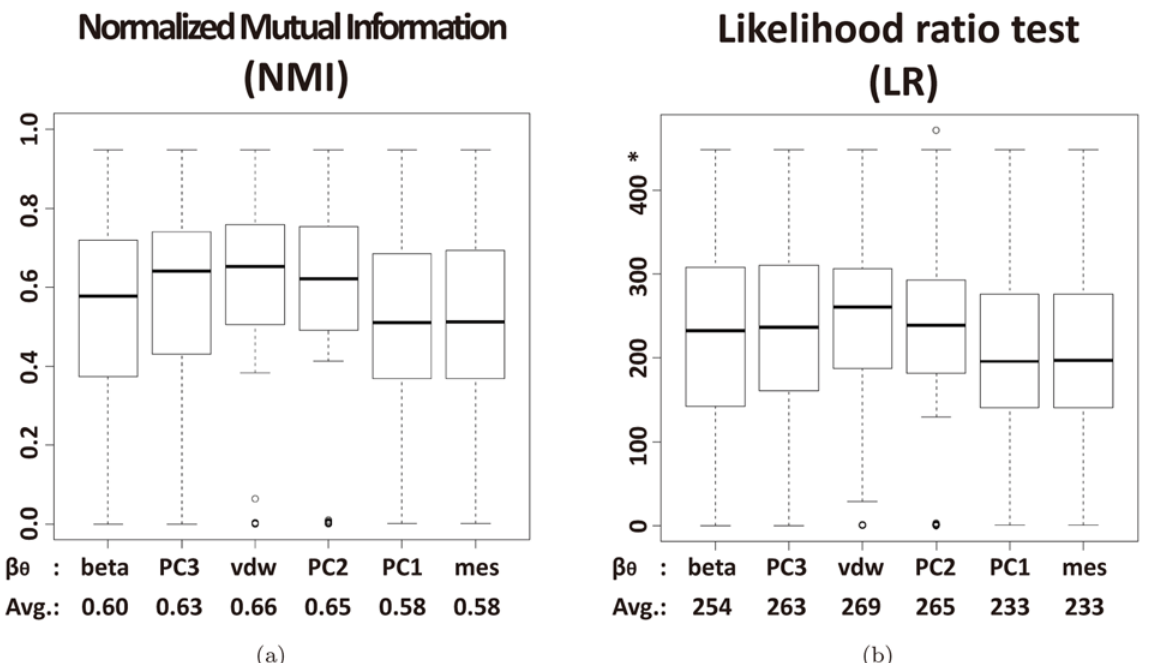
Fig 13. Box plots by entropy-based metrics of the six types of L-descriptor. (a) normalized mutual information and (b) Likelihood ratio. * Note that the y- axis scale of the LR plot is different from the NMI plot ’ s.